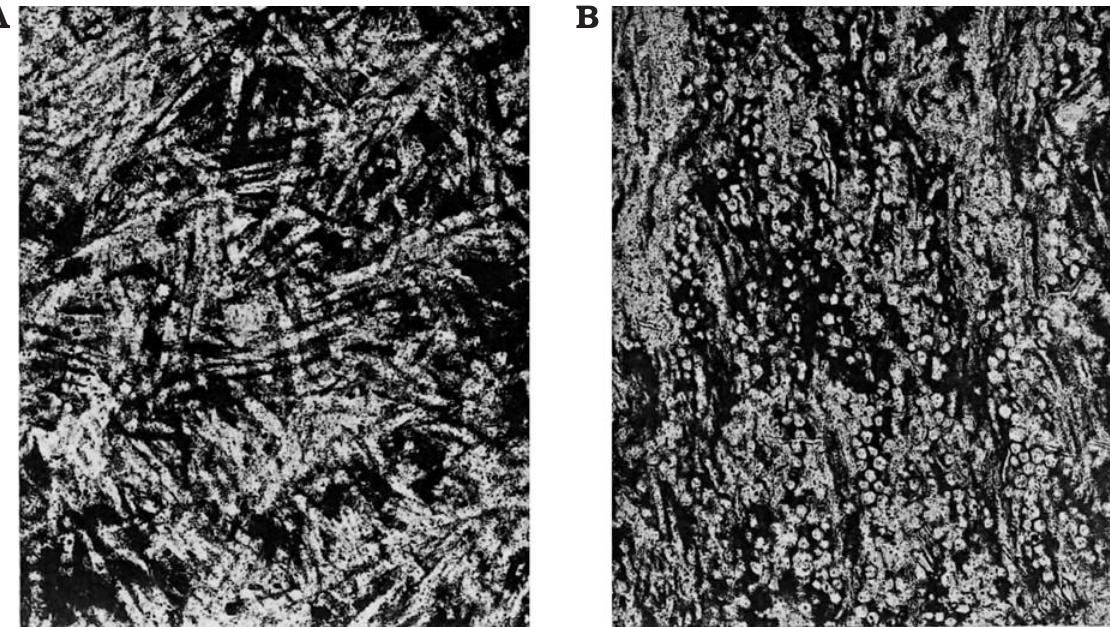
Fig. 9. Spongillida gen. et sp. indet, sensu Cayeux (1929). Stephanian, upper Carboniferous; Montgros, Gard of the Massif Central, France. Freshwater spiculites where spicules (200–250 μ m long) are horizontally arranged ( A ) and cross cut ( B ). Modified from Cayeux (1929: pl.